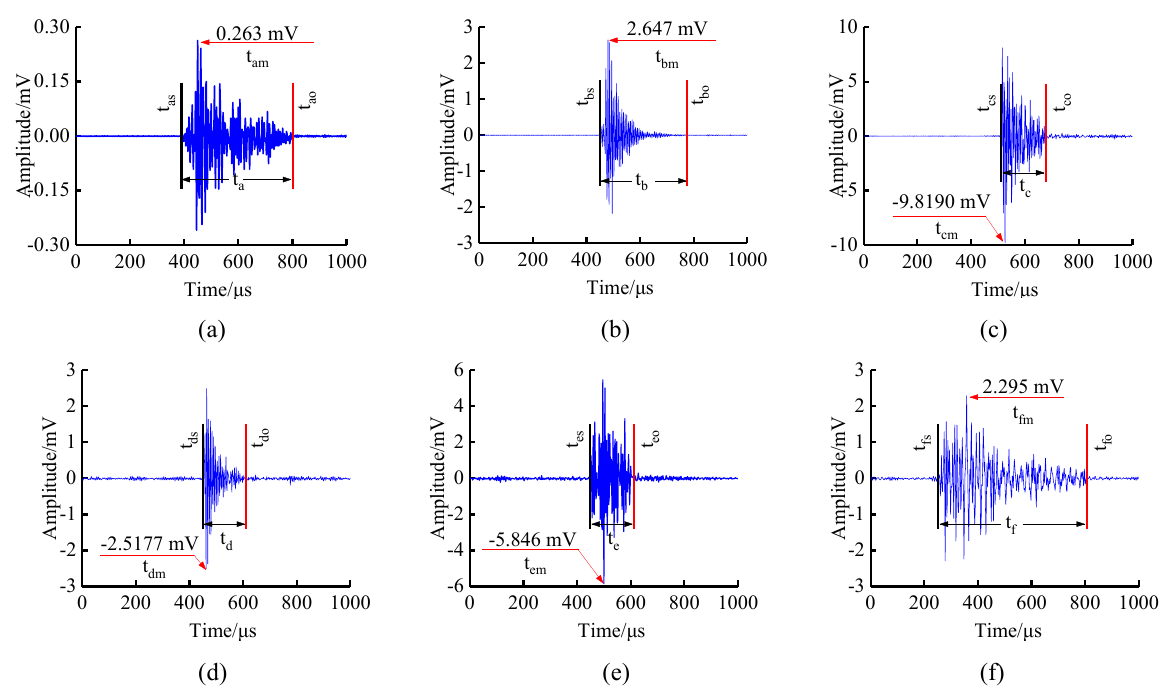
Figure 8. Amplitude diagram of key points in HF. ( a ) Initial point a, ( b ) Leap point b, ( c ) Rupture point c, ( d ) Leap point d, ( e ) Critical point e, and ( f ) End point f. Table 4. Time–domain waveform parameters of the key points.